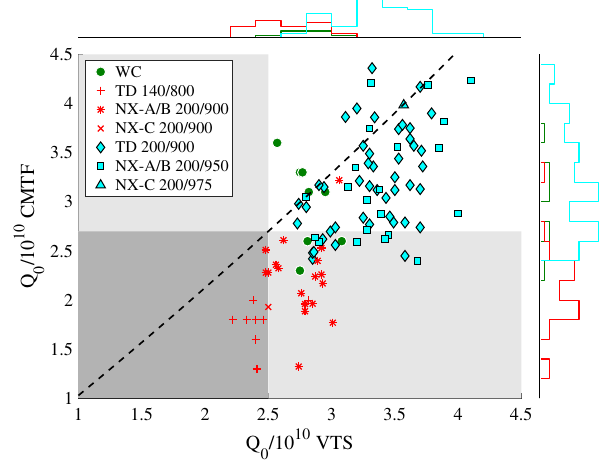
FIG. 8. Q 0 measurements of each cavity in Fermilab LCLS-II CM01-13, showing a strong correlation to the heat treatment temperature of the cavity for a given material. The red symbols (plus, asterisk, and times) represent cavities that were treated at too low of a temperature for that material to have strong flux expulsion (see CAV0007 in Fig. 6). The blue symbols (diamond, square, and triangle) represent cavities that were heated at a sufficiently high temperature (see CAV0019 in Fig. 6). The green symbols circle represent cavities from the prototype cryomodule, and are considered separately, as they were fabricated previously and therefore not using LCLS-II production material. Q 0 data are shown for measurements in both vertical test (VTS) and cry- omodule test (CMTF). The gray boxes are related to the Q 0 specifications as explained in the text. Histograms on the top and right side of the scatter plot show counts of cavities binned by Q 0 , separated into three categories corresponding to the color of the symbols in the scatter plot. All data measured at 16 MV = m and 2.0 K after high mass flow cooldown. Note that stainless steel flanges are expected to add ∼ 0 . 8 n Ω of surface resistance in vertical test, which is accounted for by the dashed